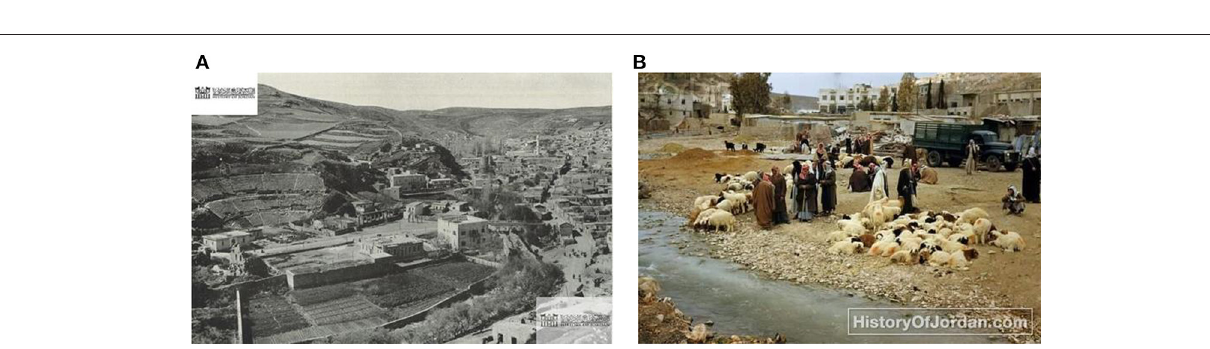
FIGURE 8 | (A) The Amman Stream in 1944 when it provided a crucial green-blue corridor surrounded by farms, gardens, and a cattle market. A bridge is also visible (photo credit: the History of Jordan); (B) An historic photo from 1950 showing the cattle market by the Amman Stream (photo credit: the History of